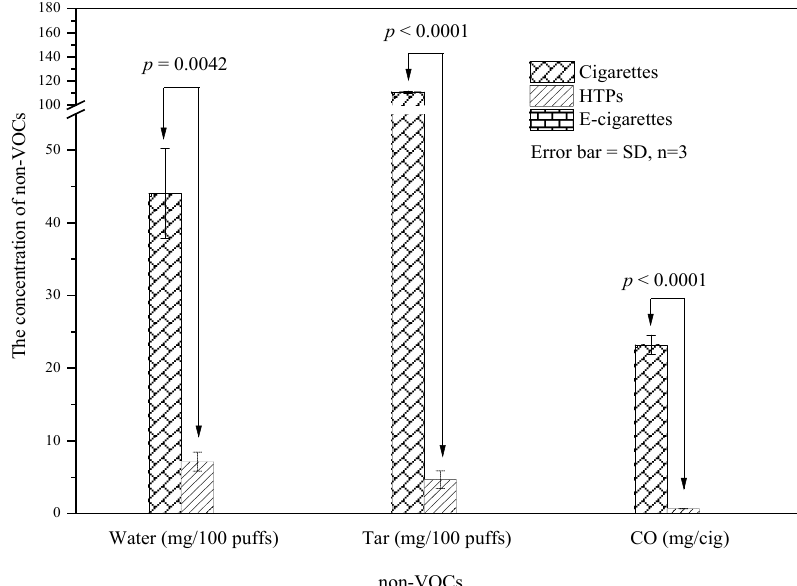
Figure 5. Concentrations of non-VOCs emitted from different types of tobacco products.